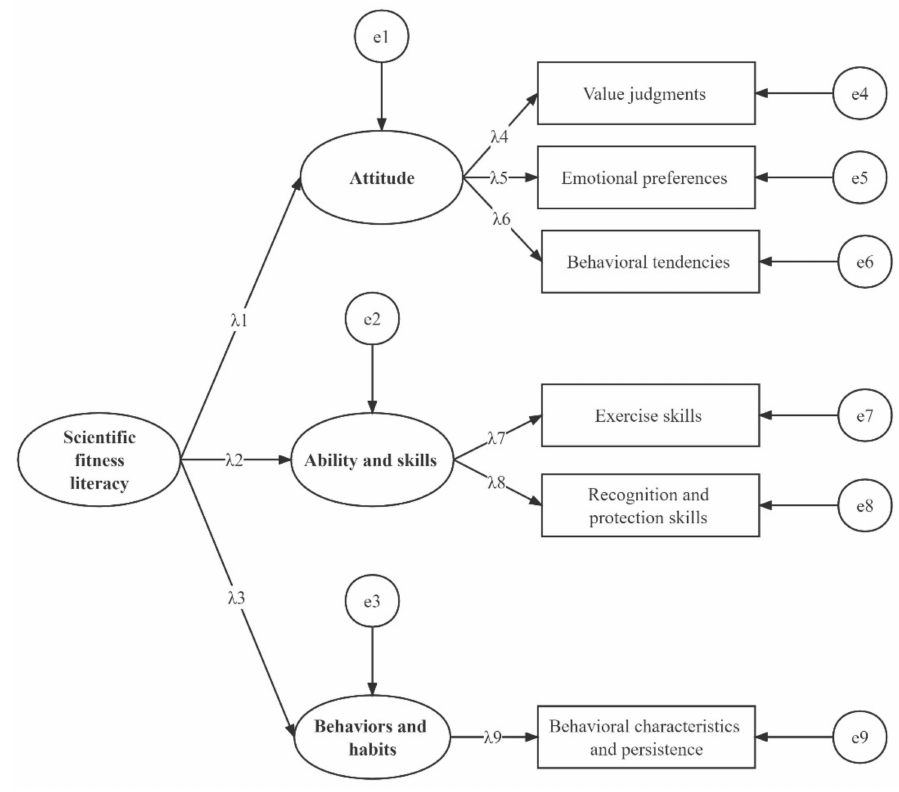
Figure 2. Confirmatory factor analysis model of scientific fitness